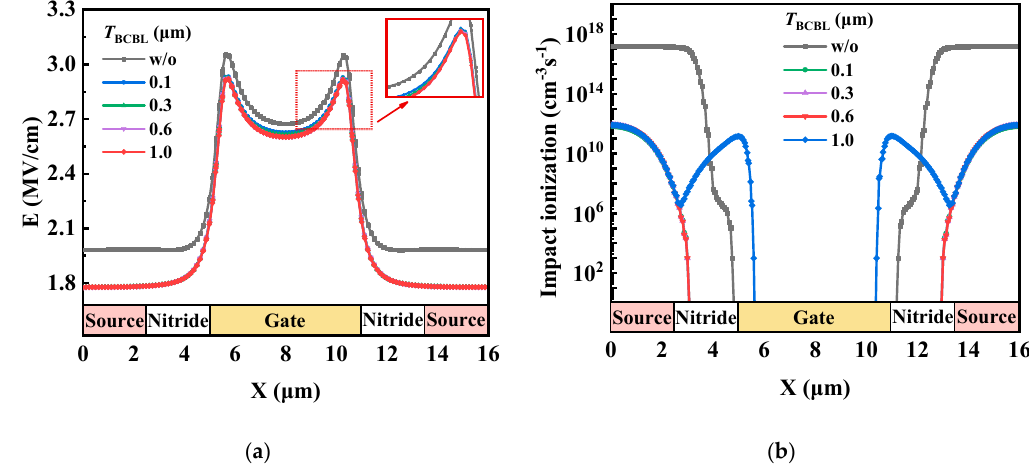
Figure 9. Distributions of ( a ) electric field and ( b ) impact ionization concentration around the gate in the BCBL-VFET with the changed T BCBL .